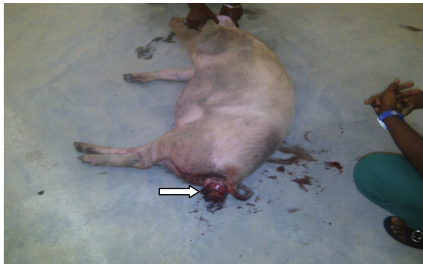
Figure 1: The pig at presentation. Note the arrow pointing at the prolapsed rectum.